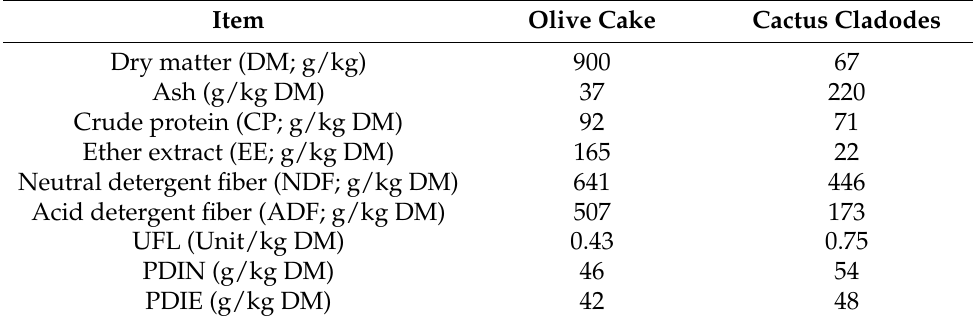
Table 1. Chemical composition of olive cake and cactus cladodes. Item Olive Cake